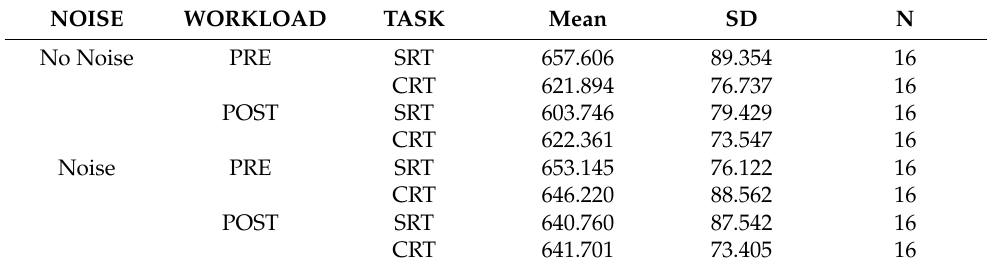
Table 3. Descriptive